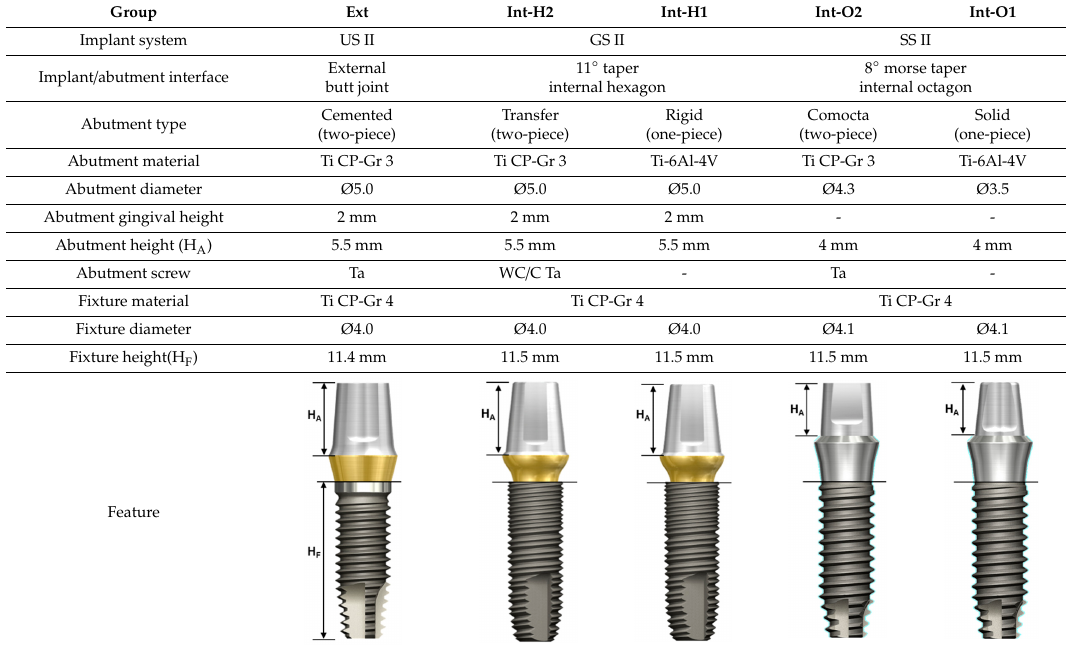
Figure 1. Schematic drawing of the test setup. Ext: external hexagon fixture + Cemented abutment; Int-H2: internal hexagon fixture + two-piece abutment; Int-H1: internal hexagon fixture + one-piece abutment; Int-O2: internal octagon fixture + two-piece abutment; Int-O1: internal octagon fixture + one-piece abutment. Ten implant-abutment assemblies were constructed for each group (total n = 50). Each assembly was held in a vise during the torque tightening procedure. The desired torque was applied to the abutment screw with a digital torque gauge (MGT12, MARK-10 Co., Hicksville, NY, USA). The schematic diagram of experimental design based on protocol sequence is presented in Figure 2. Each abutment was tightened into the corresponding implant at 30 Ncm torque twice at 10 minute intervals. Ten minutes after the second tightening, the initial removal torque was measured with a digital torque gauge (MGT12E, Mark-10 corp, Hicksville, NY, USA). Each assembly was secured again at 30 Ncm torque, and the total length of the implant-abutment assembly was measured with an electronic digital micrometer (no. 293-561-30, Mitutoyo, Japan). After the initial measurement of the total length, a metal cap fabricated to reproduce the crown was mounted on the